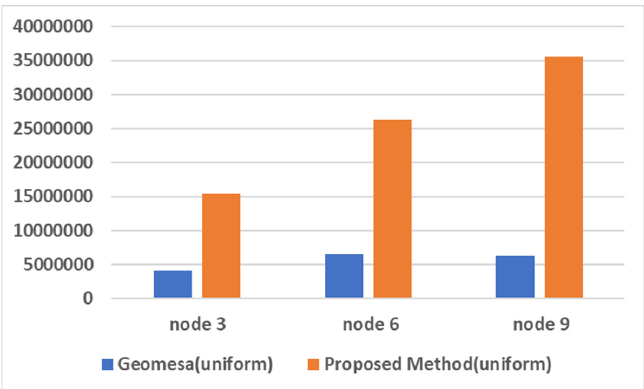
Figure 10. Ingestion throughput of Geomesa and the proposed method (Ingestion throughput: number of insertion operations per second).